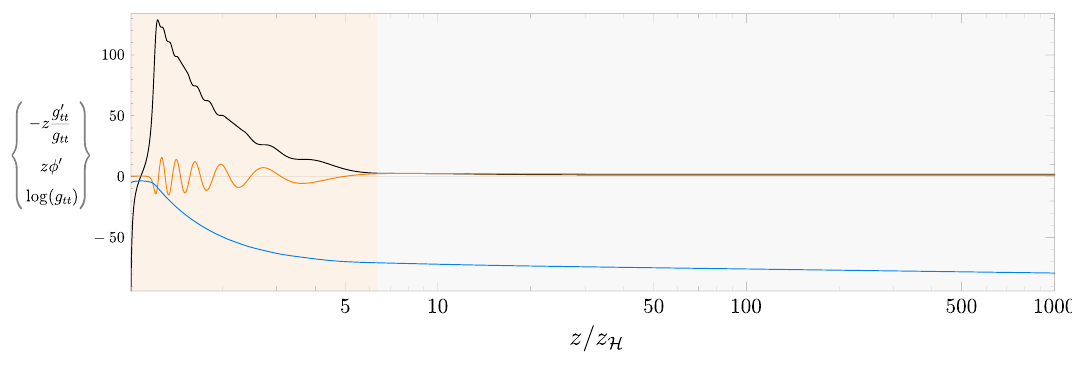
Figure 7: An example of an interior evolution with no Kasner inversion, because the intermediate Kasner exponent is already positive. Numerics with m 2 = − 2, q =